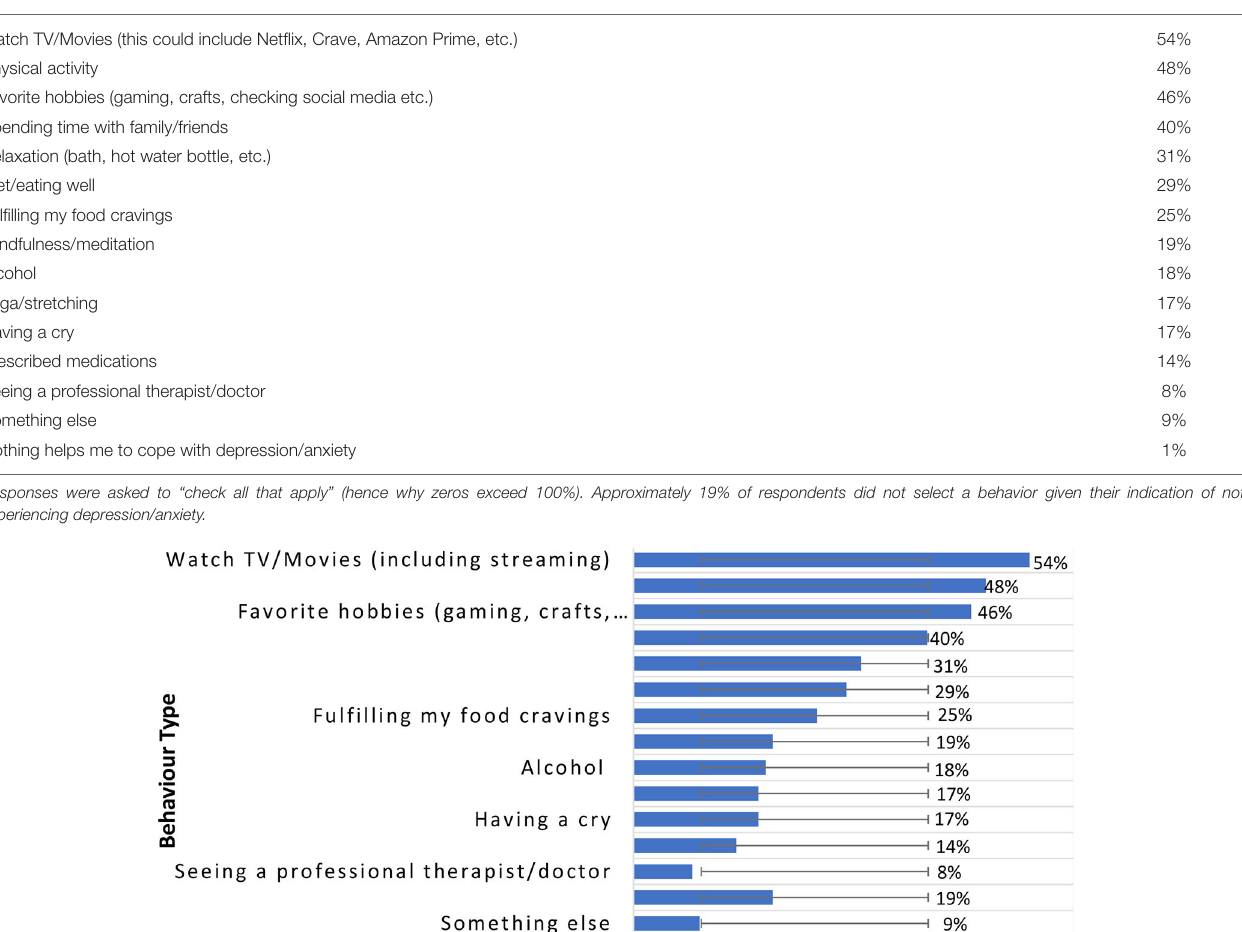
TABLE 1 | Mental health coping behaviors among Canadians during COVID-19 ( n = 1,472). Behavior type Percent of